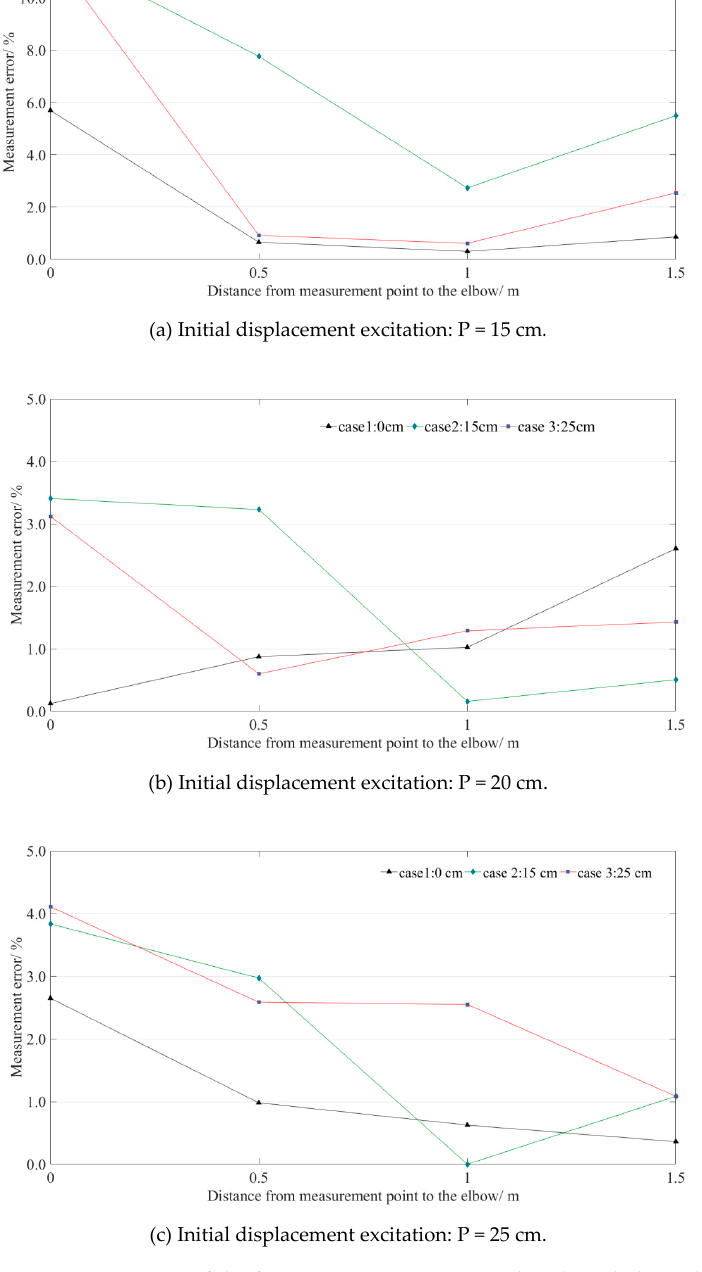
Figure 14. Measurement errors of the four measurement points distributed along the pipeline.